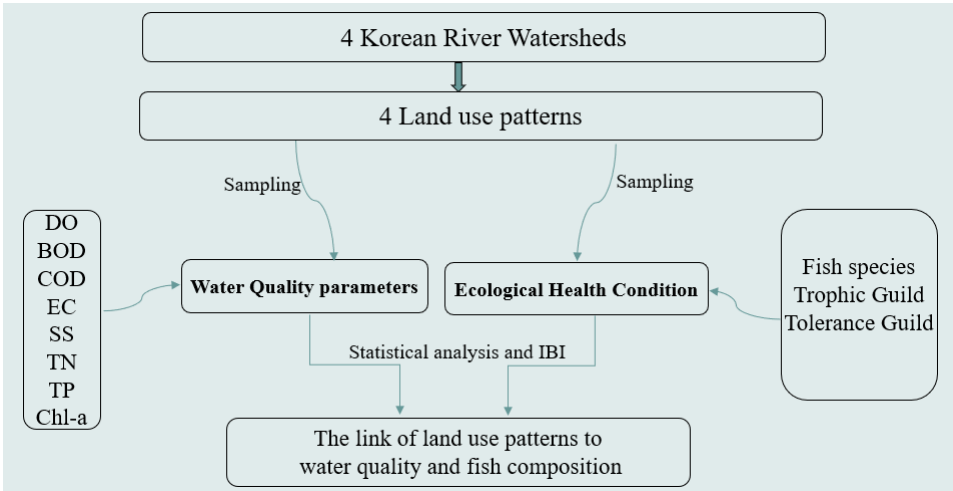
Figure 2. Methodological flow chart for this